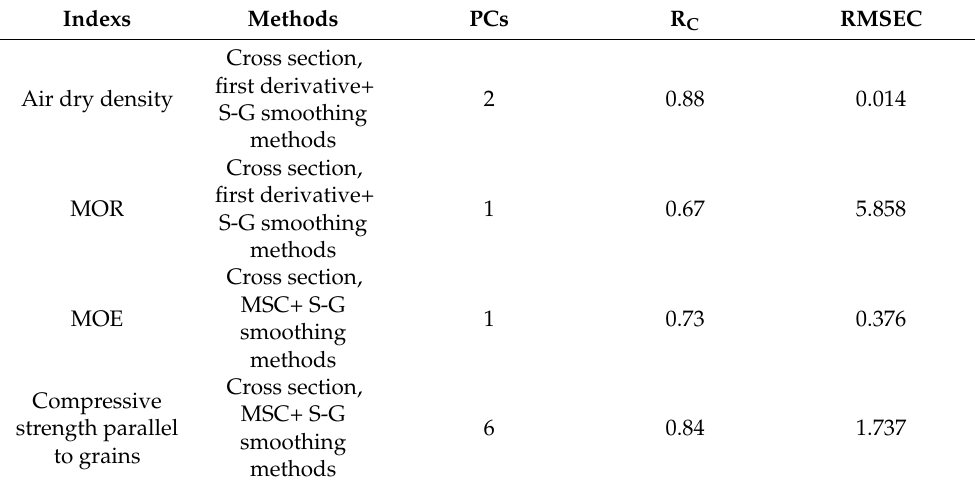
Table 7. Partial least squares (PLS) calibration models for different